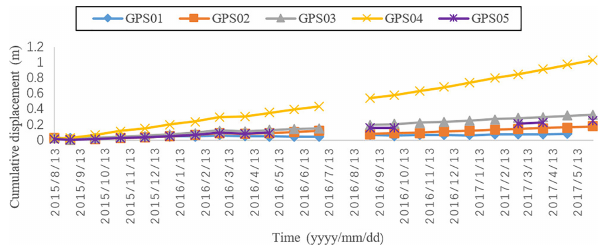
Figure 4. The GPS-derived time-series displacement of the Xishan